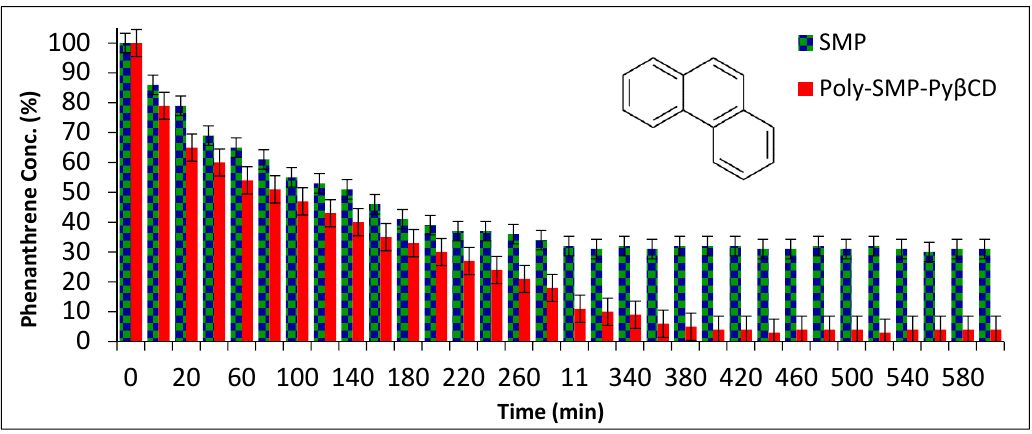
Figure 3. Phenanthrene (structure shown in the graph) adsorption from aqueous solution by the SMP and Poly-SMP-Py β CD ( 4 ).